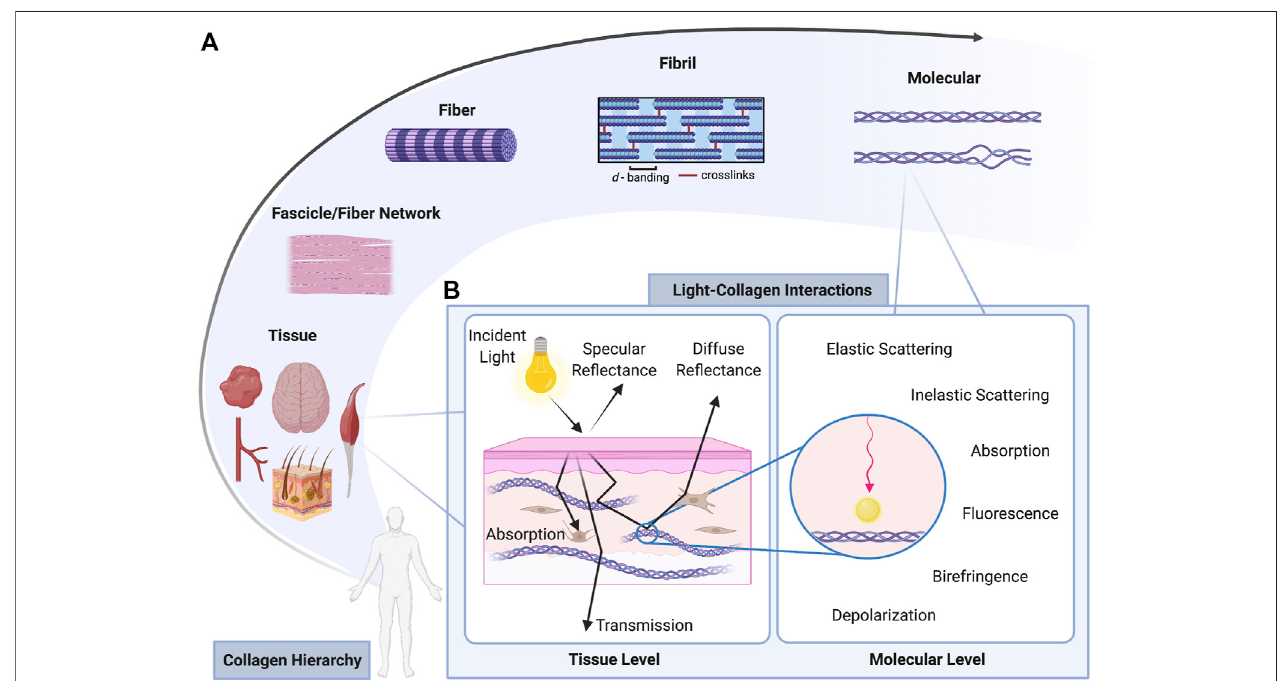
FIGURE1|(A:CollagenHierarchy) Collagenoustissuesarearrangedhierarchicallywheretissuesarecomprisedoffasciclesor fi bernetworksthatareformedof fi bers, which themselves are comprised of quarter-staggered and crosslinked fi brils. At the smallest length scale is the triple helical structure of collagen, which can become unwound when damaged or in periods of disease (B: Light-Collagen Interactions) . When light is incident on a tissue, a portion of light is lost in the form of specular re fl ectance. The portion of light that enters the tissue interacts with the collagenous, cellular, and other ECM components via several mechanisms (scattering, absorption, polarization, fl uorescence, etc). The light that penetrates the tissue travels until it is diffusely re fl ected, transmitted, or terminally absorbed. Created with BioRender.com.